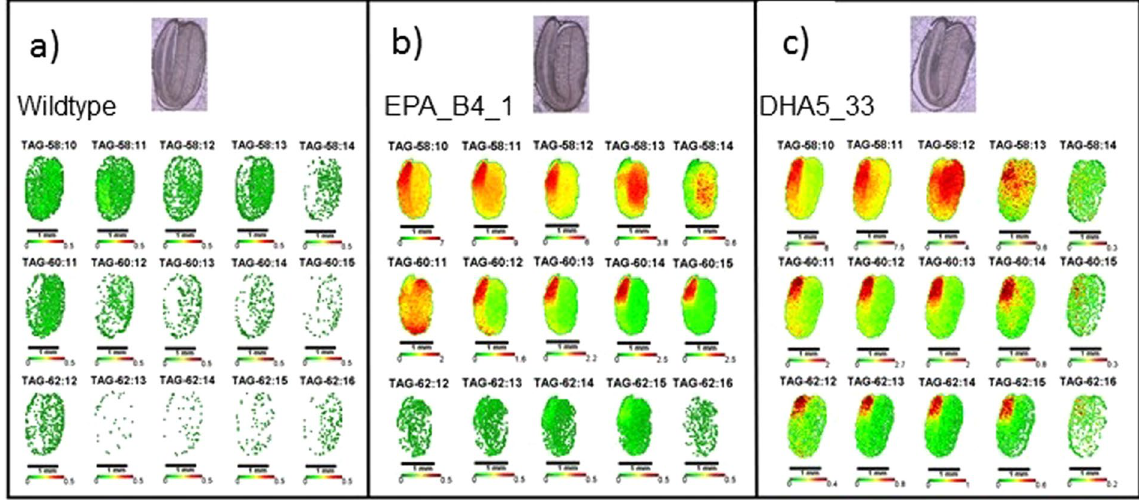
Figure 6. Representative images of TAG metabolites in mature field-grown seed of C. sativa . Cross-sections of embryos show the spatial distribution of specific TAG molecular species in wildtype ( a ), EPA_B4_1 ( b ) and DHA5_33_13 ( c ). Compare to bright-field images for orientation. False-colour images are converted from mol% of class amounts with red as the highest relative